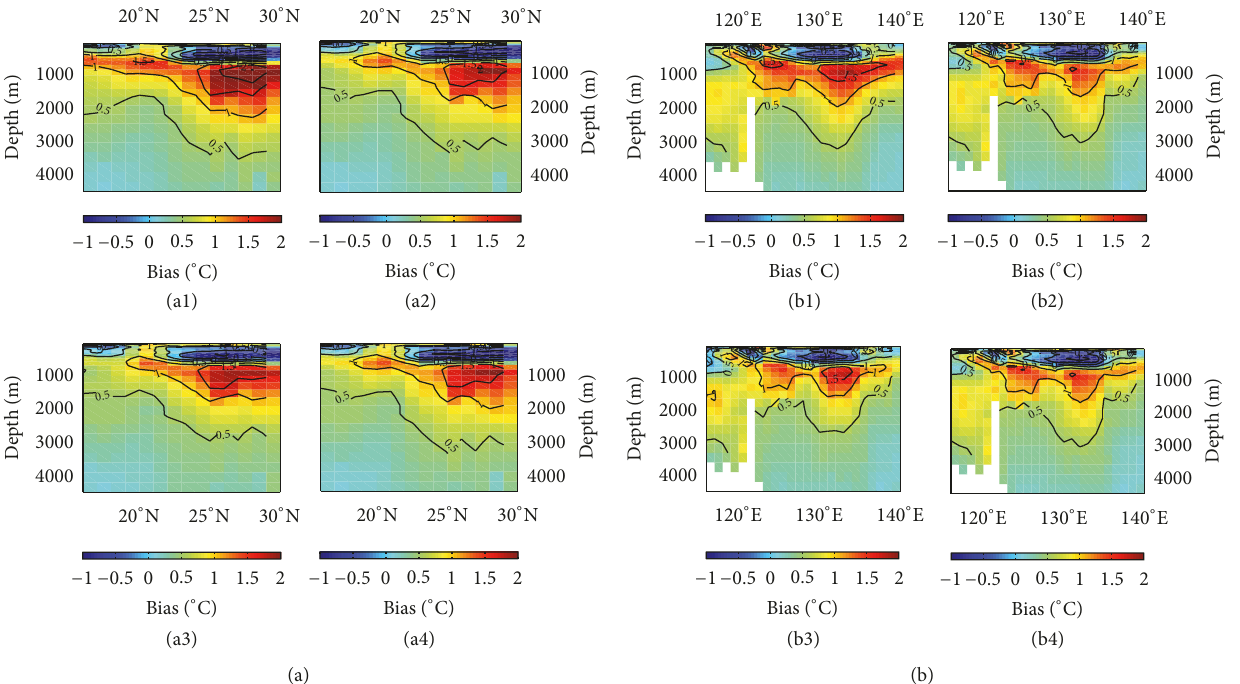
Figure 7: Zonally (a1–a4) and meridionally (b1–b4) averaged section of the difference between EN4 and the four